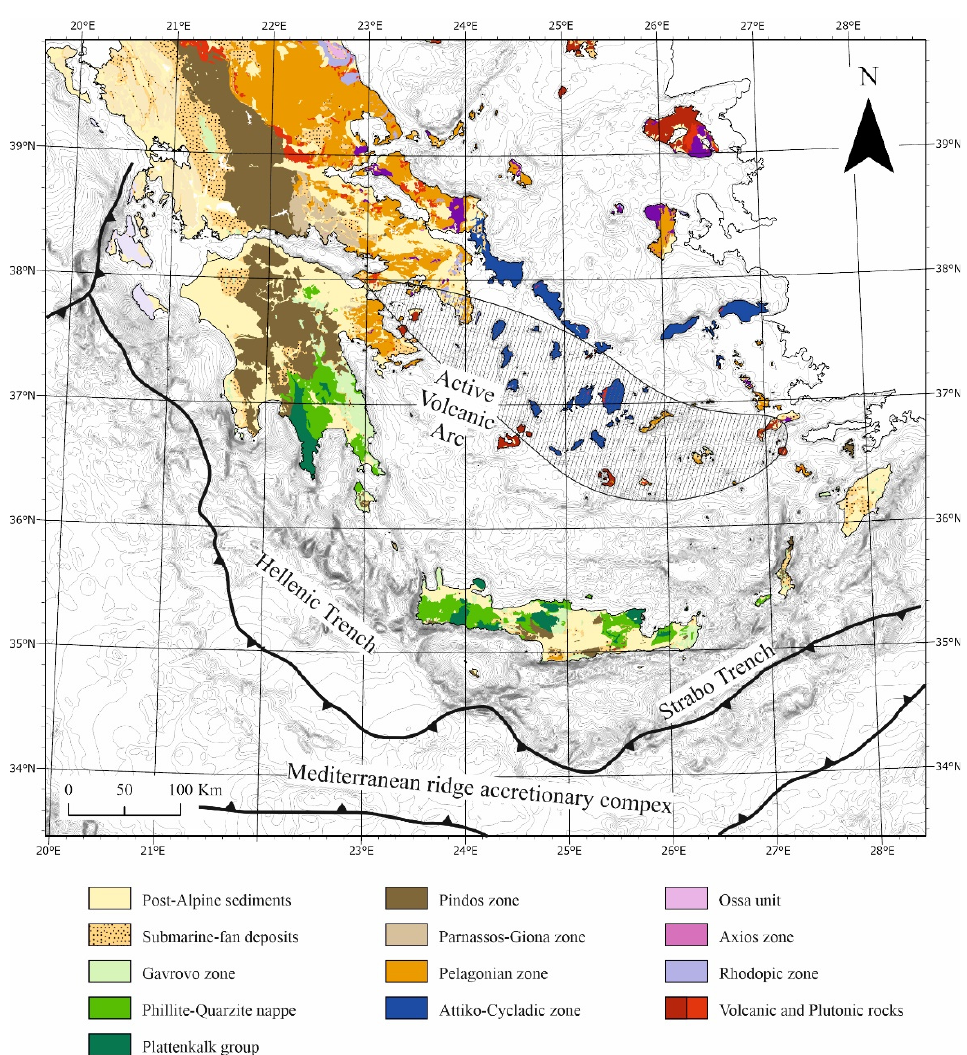
Figure 1. Scheme illustrating the tectonic zonation of Greece based on the main tectonostratigraphic zones (modified after [14] ).